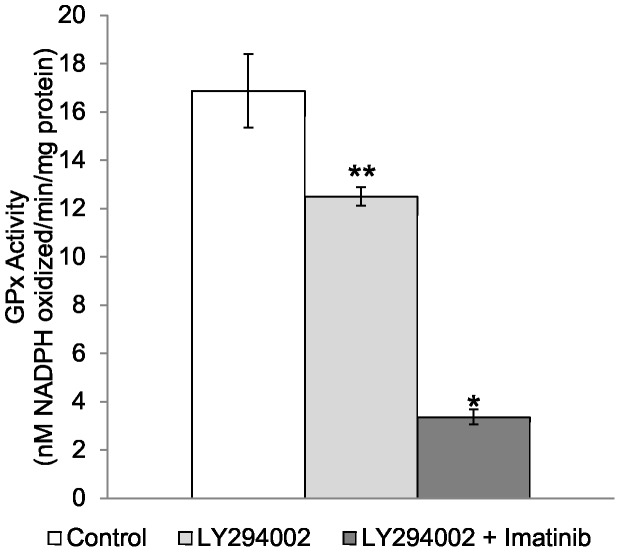
Treatment with LY294002 for 4 days inhibits PI3K phosphorylation activity and decreases GPx activity.The effect of 20 μM LY294002 treatment of KU812a cells on GPx activity levels alone or in combination with 150 nM imatinib is shown. Data presented is derived from three independent experiments. * =  P<0.001, ** = P<0.01.